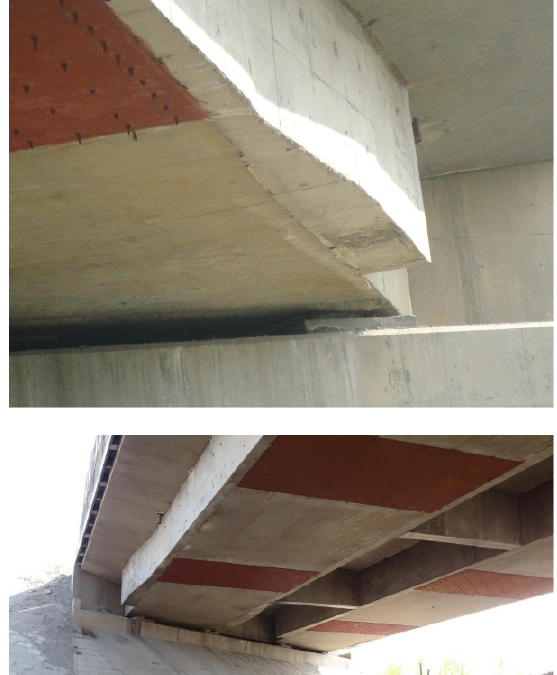
Figure 5. Thetransverselayoutofboxgirderafterfinishthestrength- ening of the outside of the webs and outside